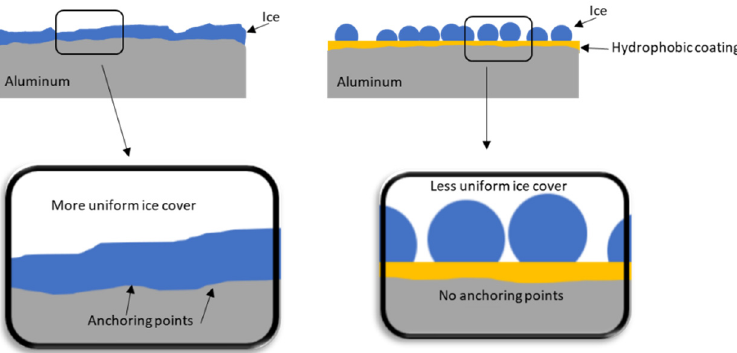
Figure 10. 2D representation of ice accumulation over bare aluminum (left portion) and over hydrophobic coating (right portion).